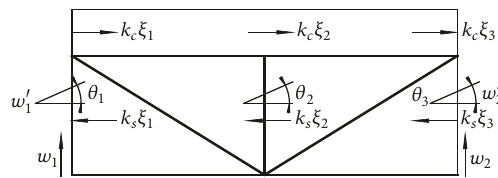
Figure 2: Nodal degrees of freedom of the SCCTB